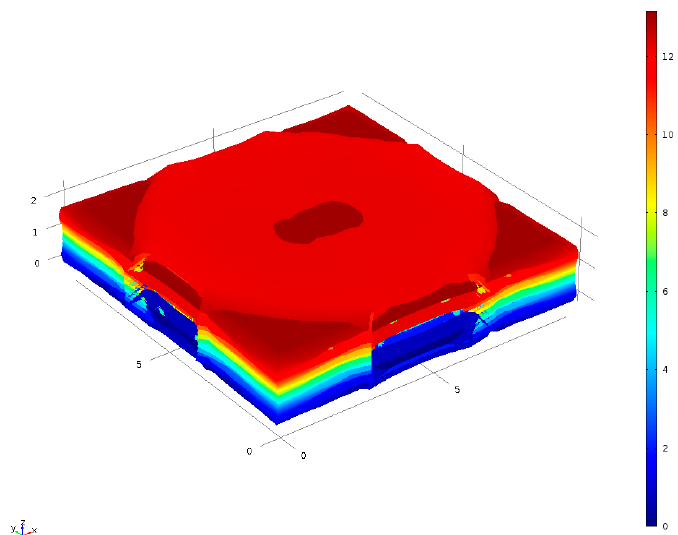
Figure 2. Simulation of pressure parameter: displacement to 2.5 mm with the PLA’s Young’s modulus at 100 °C and a pressure application of 0.5 MPa, displacement shown in mm.